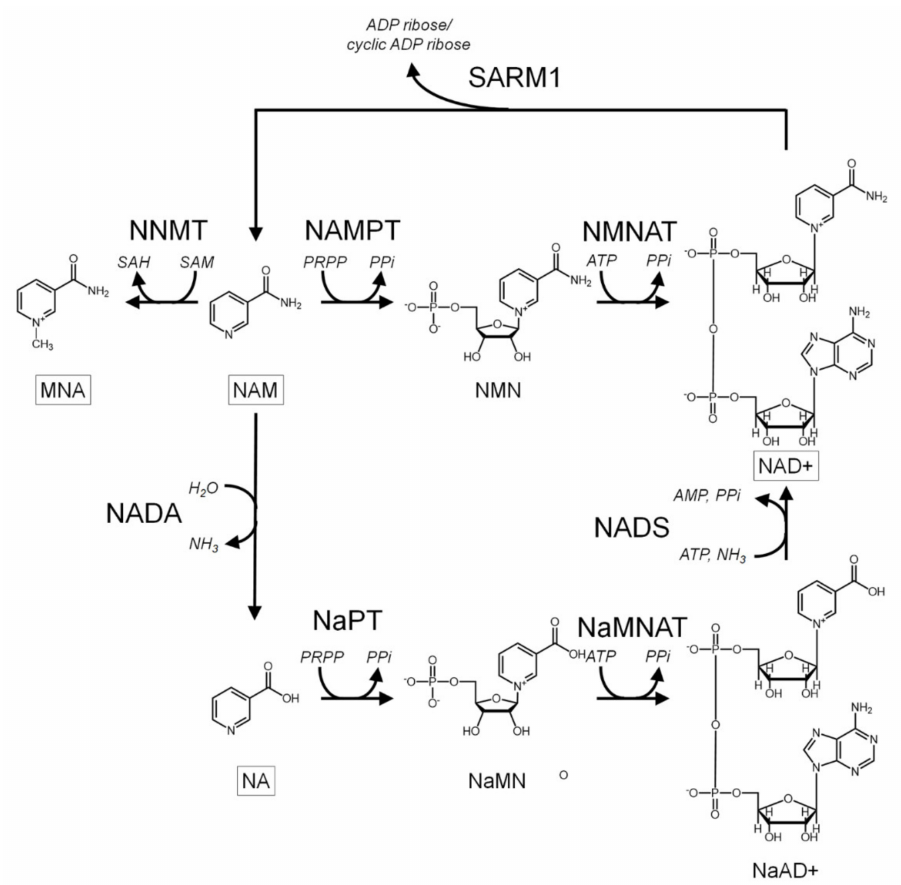
Figure 2. Summary of NAD+ synthesis using nicotinamide as substrate. In vertebrates, NAD+ is synthesised primarily from nicotinamide, obtained either from the diet or the actions of NAD+-consuming enzymes, via the salvage pathway. NAD+ is also cleaved by the NAD+-ase SARM1, releasing nicotinamide plus the signalling molecule (cyclic)ADP-ribose. Levels of nicoti- namide are regulated by the N -methylation of nicotinamide, producing 1-methylnicotinamide, by nicotinamide N -methyltransferase. In invertebrates, NAD+ is synthesised from nicotinic acid, pro- duced via the deamination of nicotinamide by nicotinamidase. The key intermediates in both pathways are boxed. MNA = 1-methylnicotinamide; NAM = nicotinamide; N(a)MN = nicoti- namide(ate) mononucleotide; N(a)AD+ = nicotinamide(ate) adenine mononucleotide; NA = nicotinic acid; NNMT = nicotinamide N -methyltransferase; N(a)A(M)PT = nicotinamide(ate) phosphoribosyl- transferase; N(a)MNAT = nicotinamide(ate) mononucleotide adenylyltransferase; NADA = nicoti- namidase; NADS = NAD+ synthase; SAM = S -adenosylmethionine; SAH = S -adenosylhomocysteine; PPi = pyrophosphate; NH 3 = glutamine; PPRP = phosphoribosyl